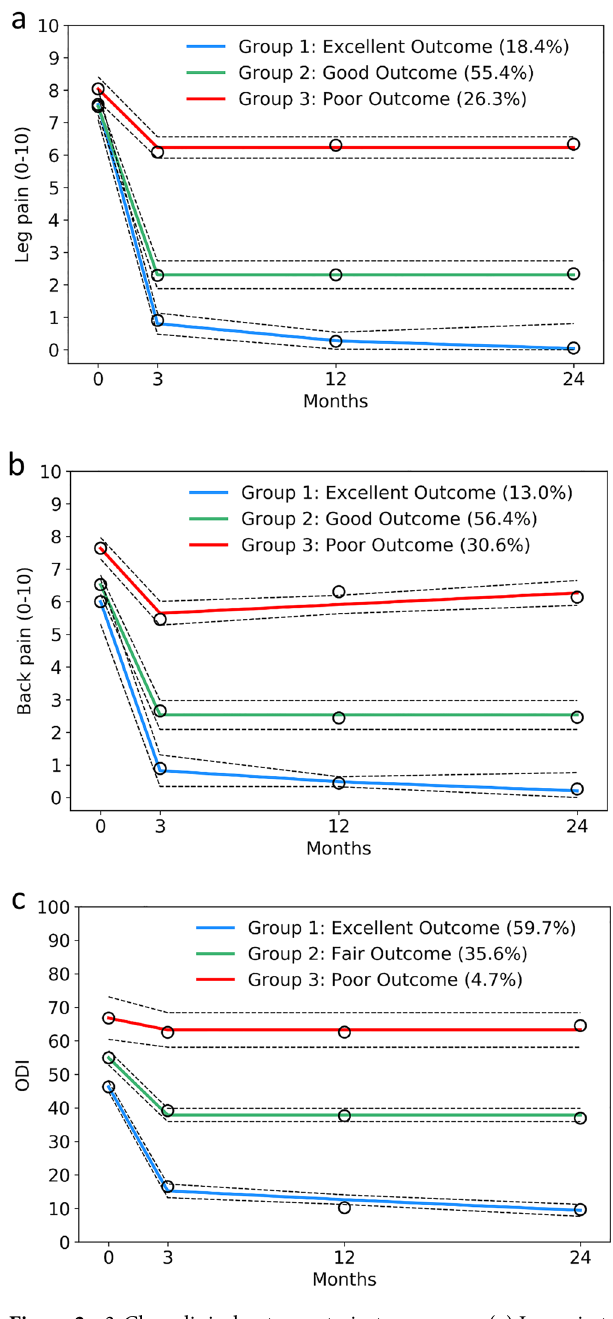
Figure 2. 3-Class clinical outcome trajectory groups. ( a ) Leg pain trajectories (N = 517); ( b ) back pain trajectories (N = 469); ( c ) disability trajectories (N = 502). Point estimates represent the mean score at each time point (0–10 numeric pain rating scale or 0–100 modified Oswestry disability index). Dotted lines represent 95% confidence